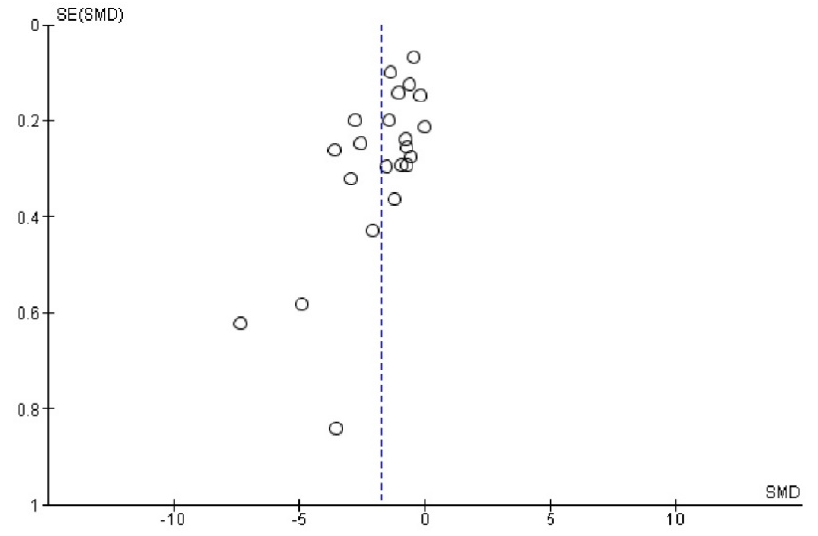
Figure A7. Forest plot of arylesterase activity in the sensitivity analysis [28,30,32,34,39,41–43,45–47].